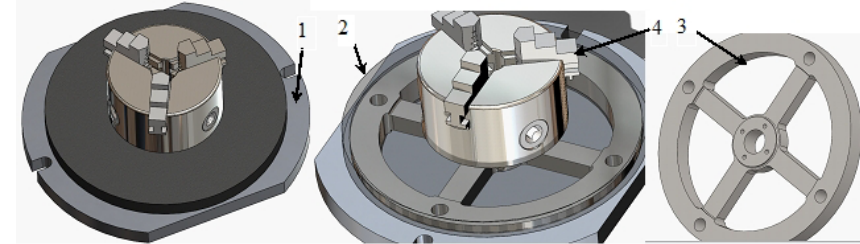
Figure 3. Assembly detail of the